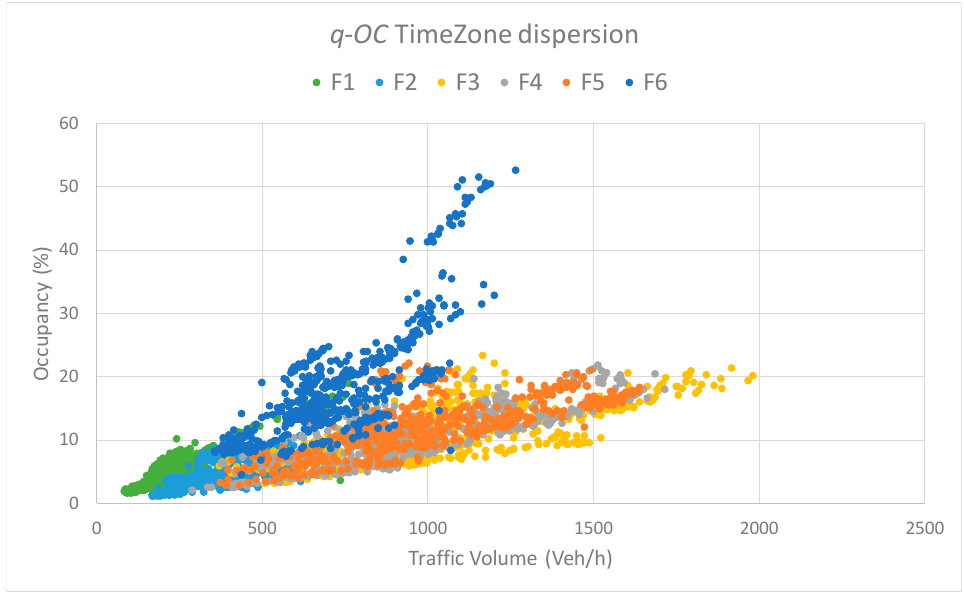
Figure 8. Average traffic volume and occupancy in June 2019 (the number of inside graph shows time frame in day e.g., 22 means the hour from 22:00 to 22:59).